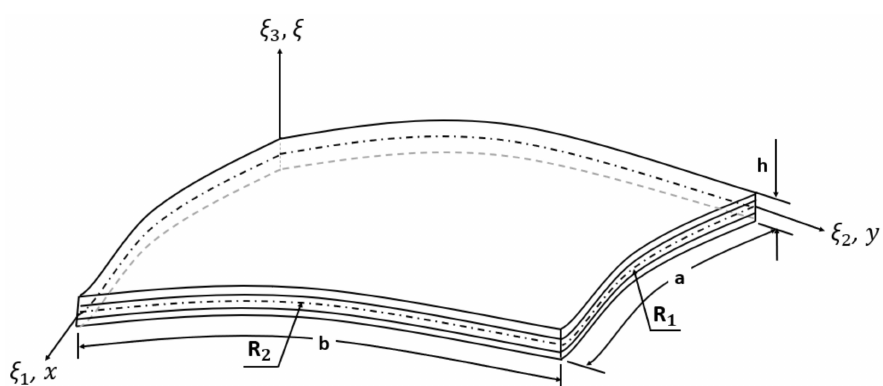
Figure 1. Geometry of a laminated doubly curved